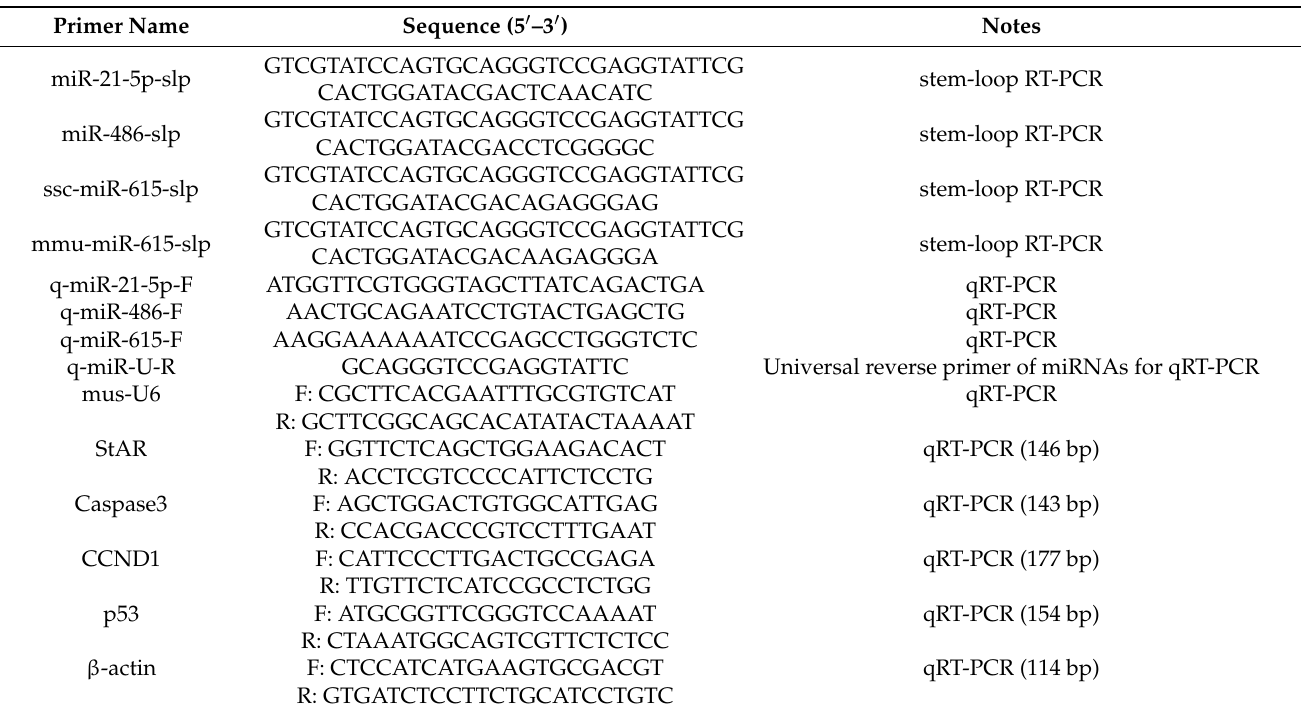
Table 1. The information of primers for RT-PCR and